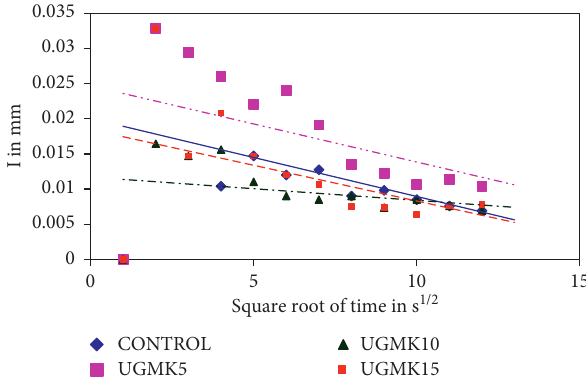
Figure 16: Sorption coefficient of